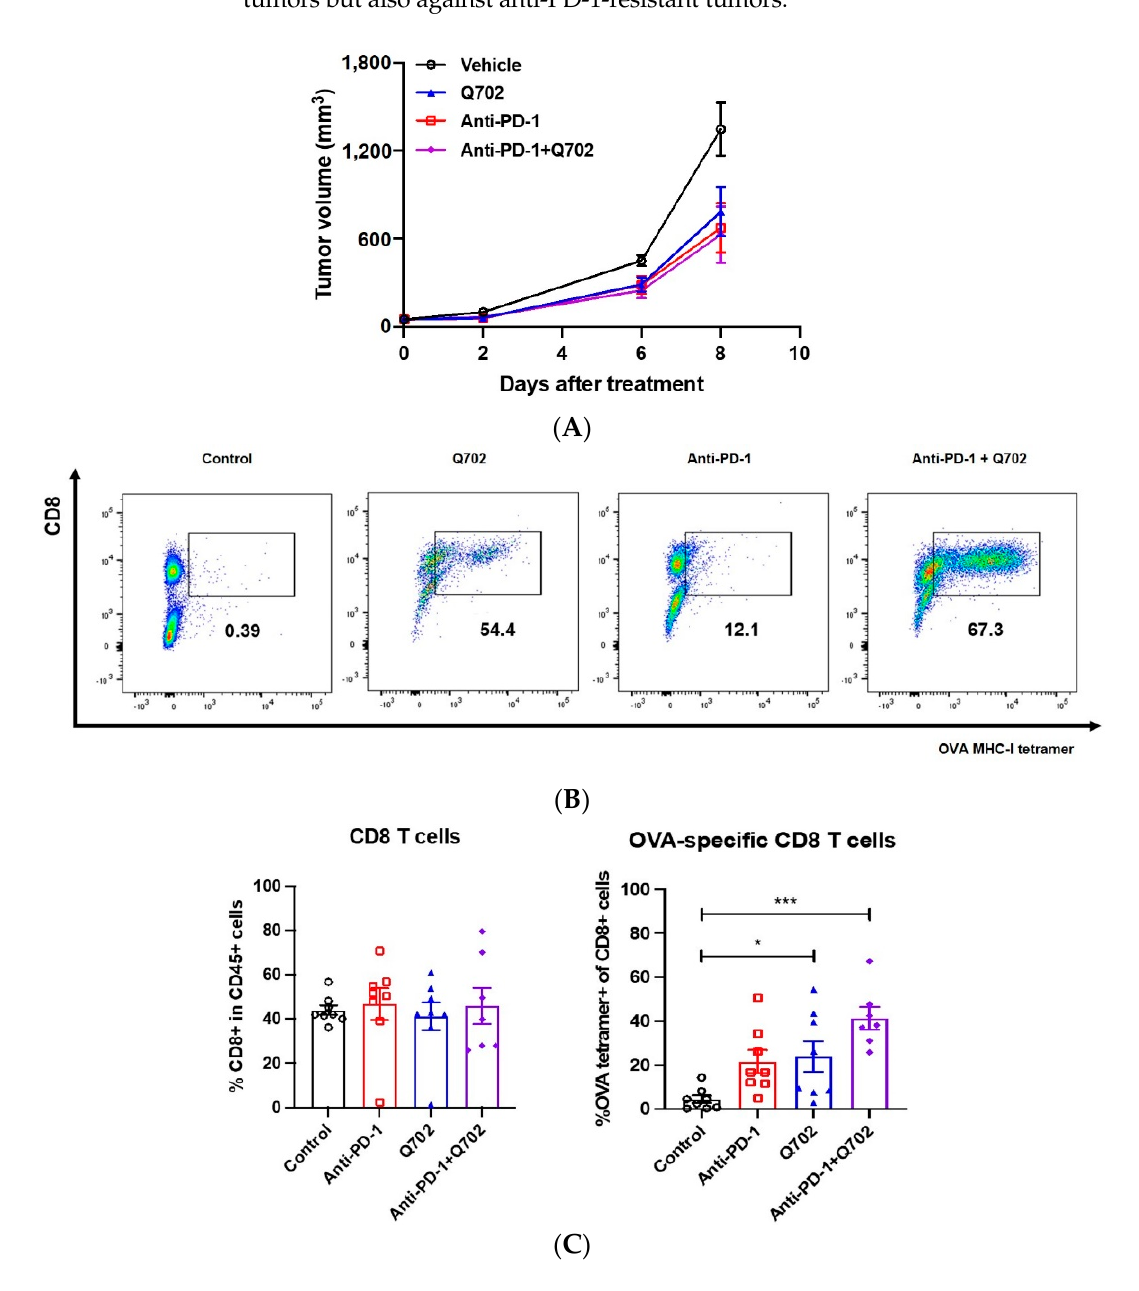
Figure 7. Q702 enhances the infiltration of tumor antigen-specific CD8 T cells into tumors. B16F10- OVA (2 × 10 5 ) cells were inoculated subcutaneously into the left flanks of female C57BL/6 mice. When the tumor size reached approximately 50 mm 3 , mice were randomized and treated with vehicle, anti-PD-1 antibody (10 mg/kg, twice a week, intraperitoneally), Q702 (30 mg/kg, once daily, oral administration), or with a combination of anti-PD-1 and Q702 for 9 days. ( A ) The graph shows the tumor growth in vivo (mean ± SEM). ( B , C ) Tumor samples were collected on day 9 post-treatment and OVA-specific CD8 T cells from tumor samples were quantified by SIINFEKL-tetramer staining. ( B ) Representative scatter plots show OVA-MHC-I-tetramer staining. ( C ) Graphs show the average percentages of CD8 T cells and OVA-specific CD8 T cells in tumor samples. * p < 0.05, *** p < 0.001, one-way ANOVA.